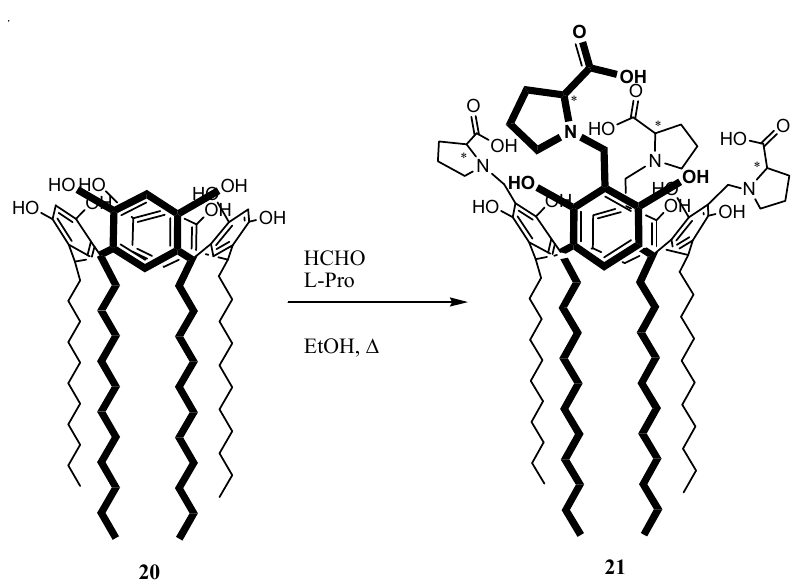
Figure 37. Synthetic route to L -RA-Pro 21 .